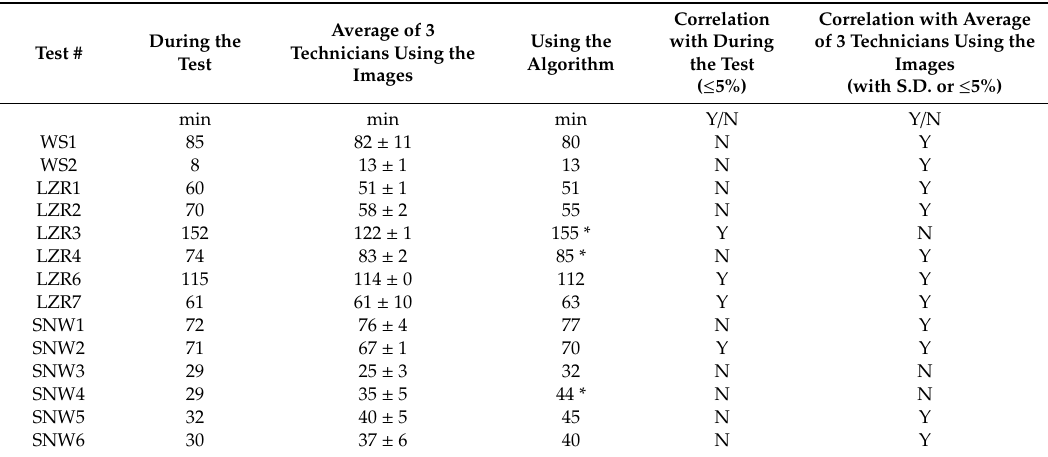
Table 1. Comparison of the algorithms with the test duration determined by the technicians.